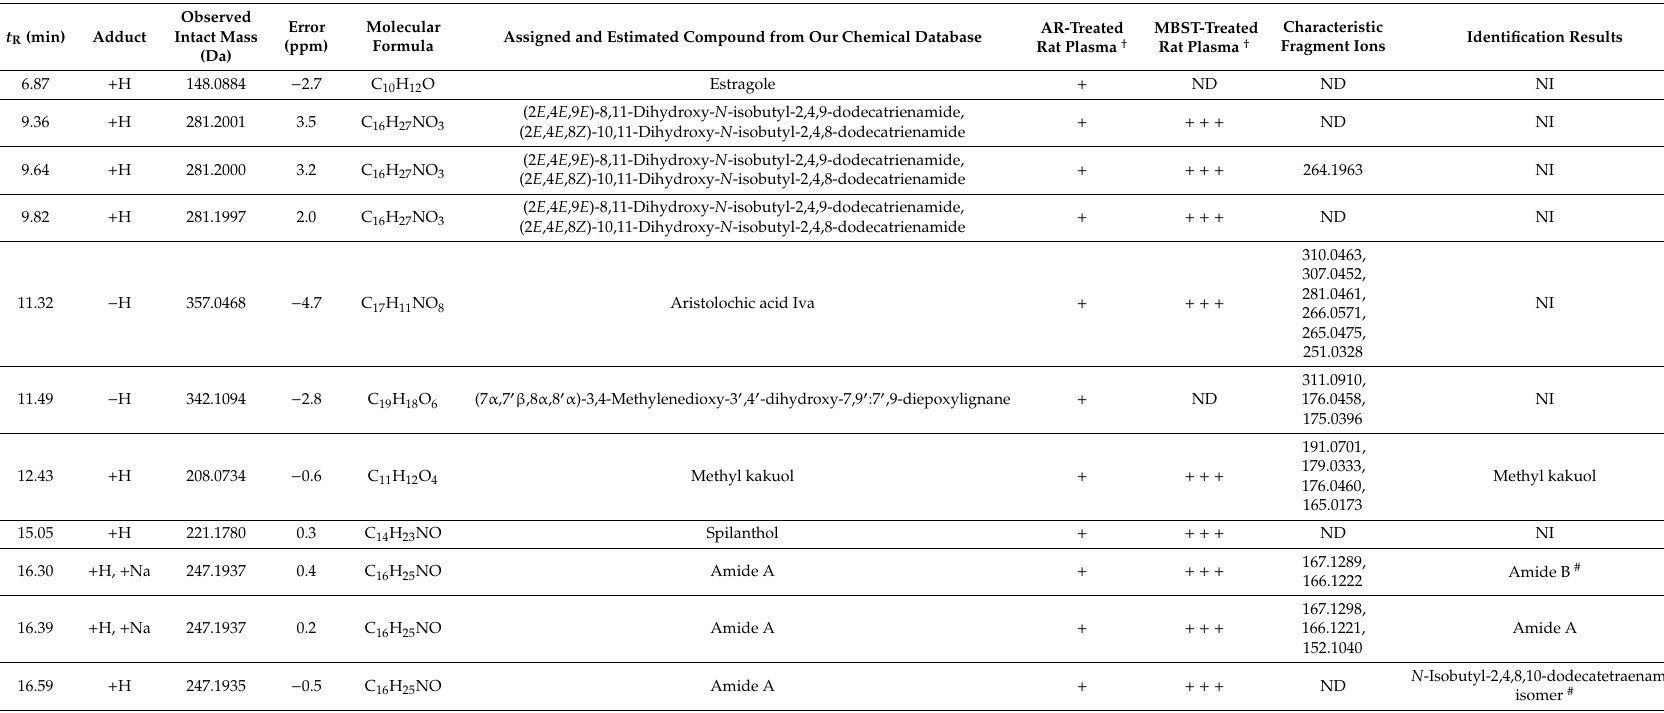
Table 1. Ingredients derived from Asiasari Radix were detected and identified in non-targeted analysis utilizing LC-HRMS. Observed t R (min) Adduct Intact Mass Error (ppm) Molecular Formula Assigned and Estimated Compound from Our Chemical Database AR-Treated